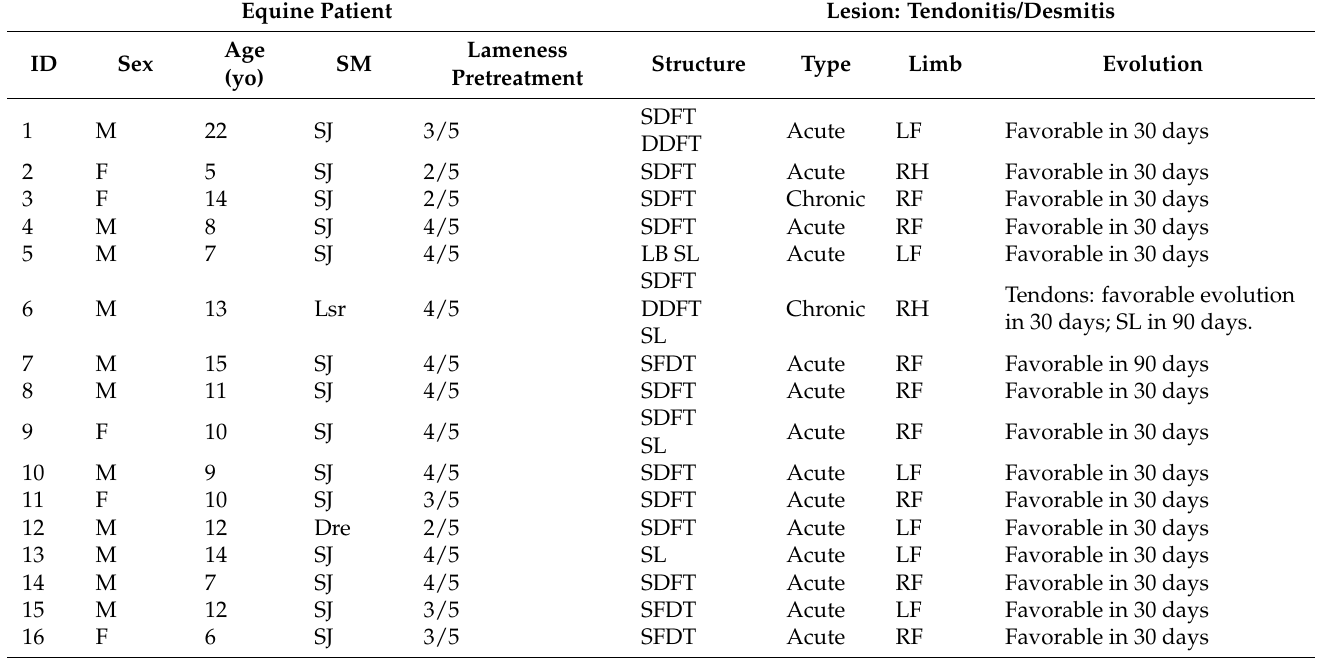
Table 2. Equine patient and lesion characterization. The left column characterizes the equine patients: Sex, male (M) or female (F); age measured in years old (yo); sports modality (SM), show jumping (SJ), dressage (Dre), and Leisure (Lsr); lameness score (AEEP score) pretreatment. The right column characterizes the lesions: Structure affected, superficial digital flexor tendon (SDFT), deep digital flexor tendon (DDFT), and suspensory ligament (SL) left branch (LB); affected limb, right frontlimb (RF), right hindlimb (RH), left frontlimb (LF) and left hindlimb (LH). Equine Patient Lesion: Tendonitis/Desmitis Structure Type Limb